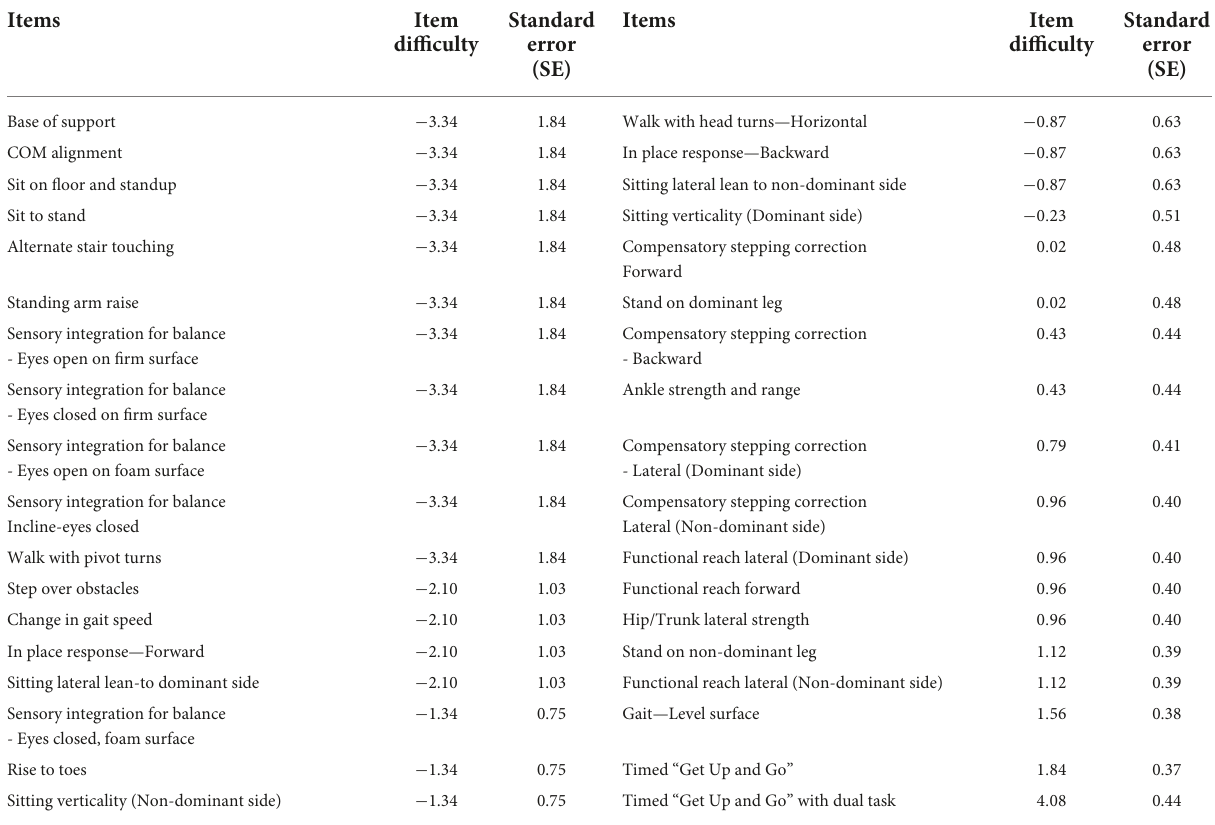
TABLE 5 Item difficulty measures of the BESTest in older adults with chronic neck pain